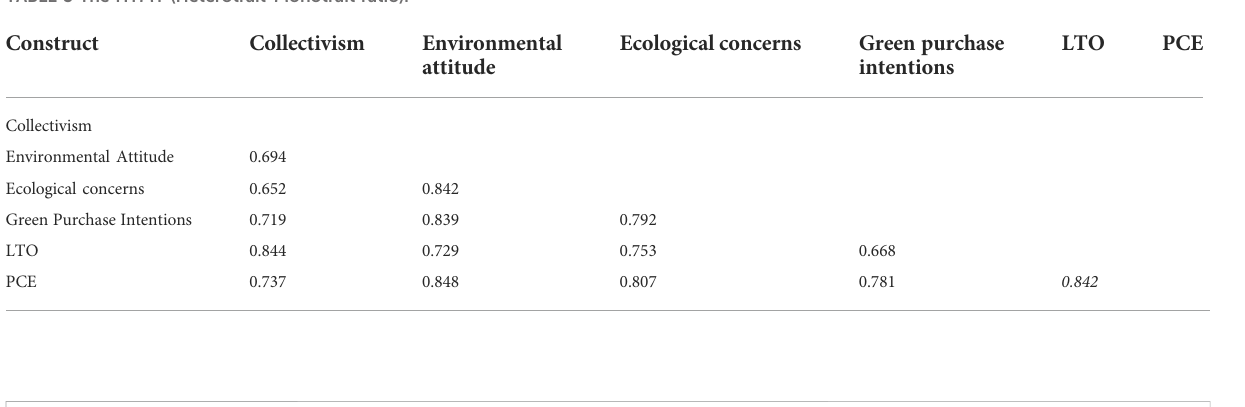
TABLE 5 The HTMT (Heterotrait-Monotrait ratio).